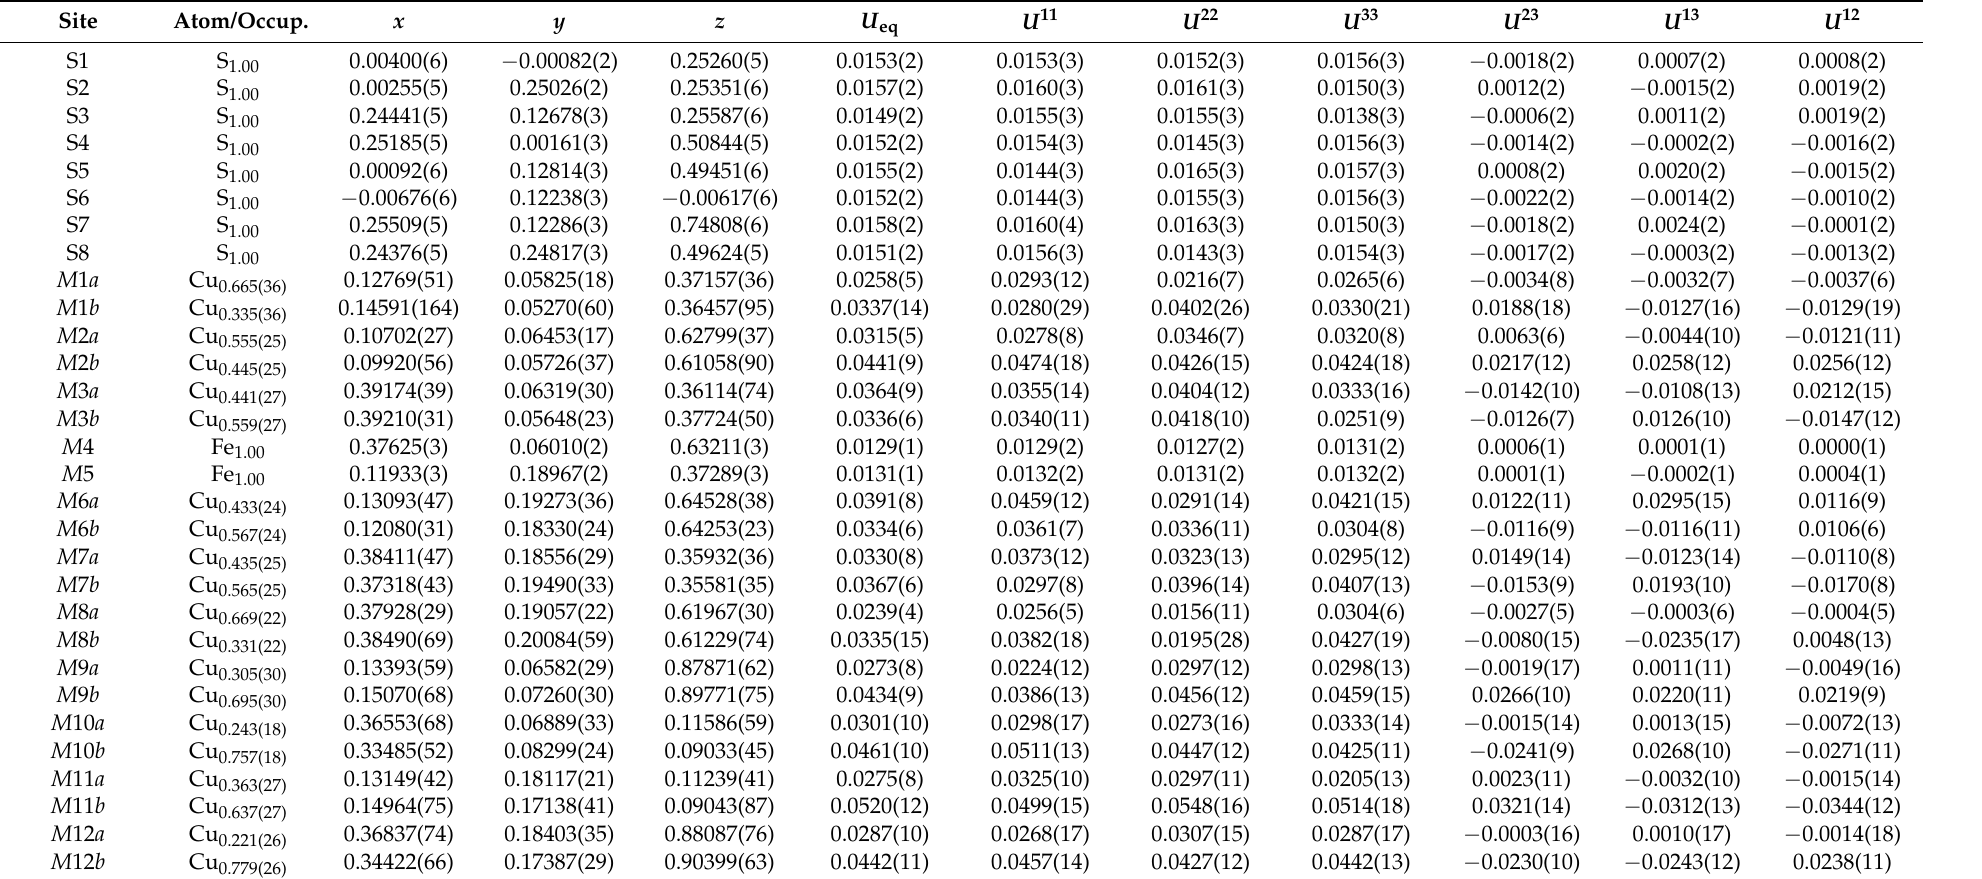
Table 3. Fractional atomic coordinates and displacement parameters (Å 2 ) of atoms in bornite from